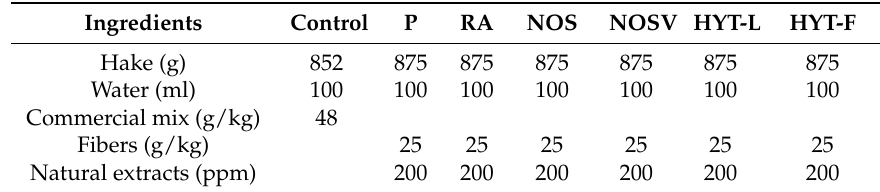
Table 1. Fish patties